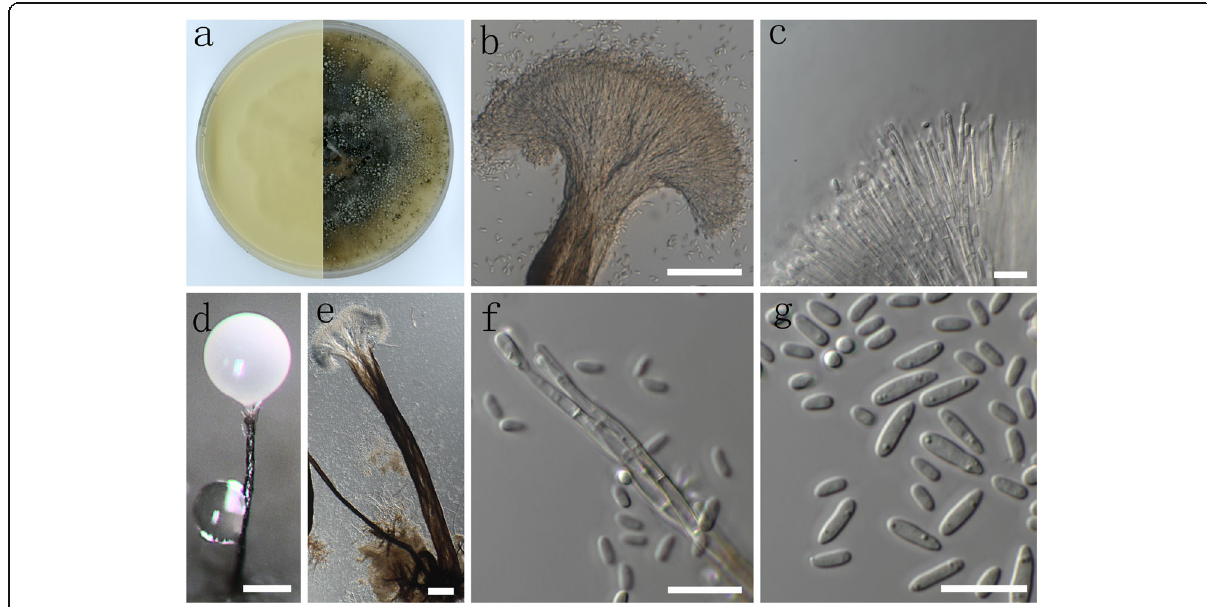
Fig. 6 Morphological characters of asexual structure of Ophiostoma kunlunense sp. nov. a Cultures on malt extract agar (MEA); b , d , e Pesotum asexual state; c , f conidiogenous cells; g conidia. – Scale bars: b = 50 μ m; c , f , g = 10 μ m; d = 200 μ m; e = 100 μ m